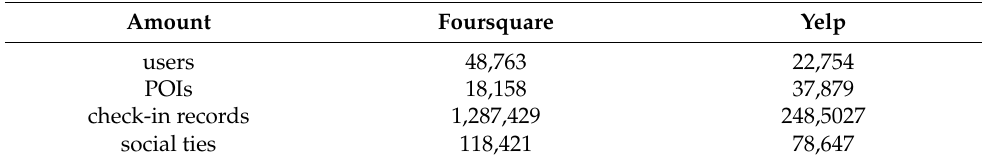
Table 2. Statistics of Datasets.